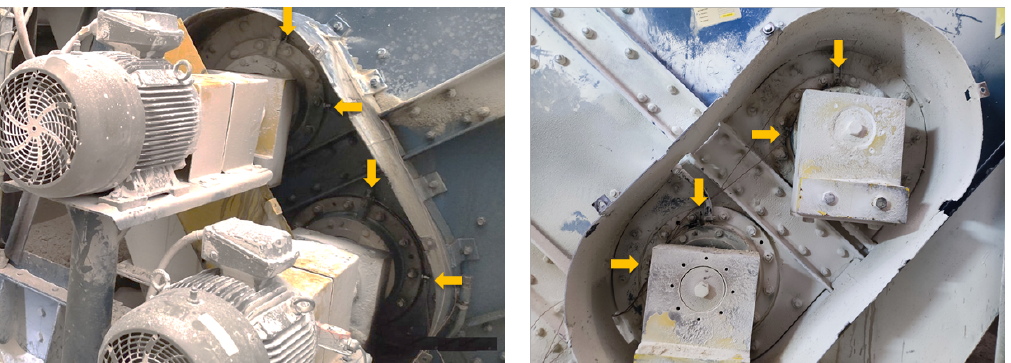
Figure 5. Vibration sensors’ (accelerometers) placement on the upper and lower shafts of the vibrat- ing